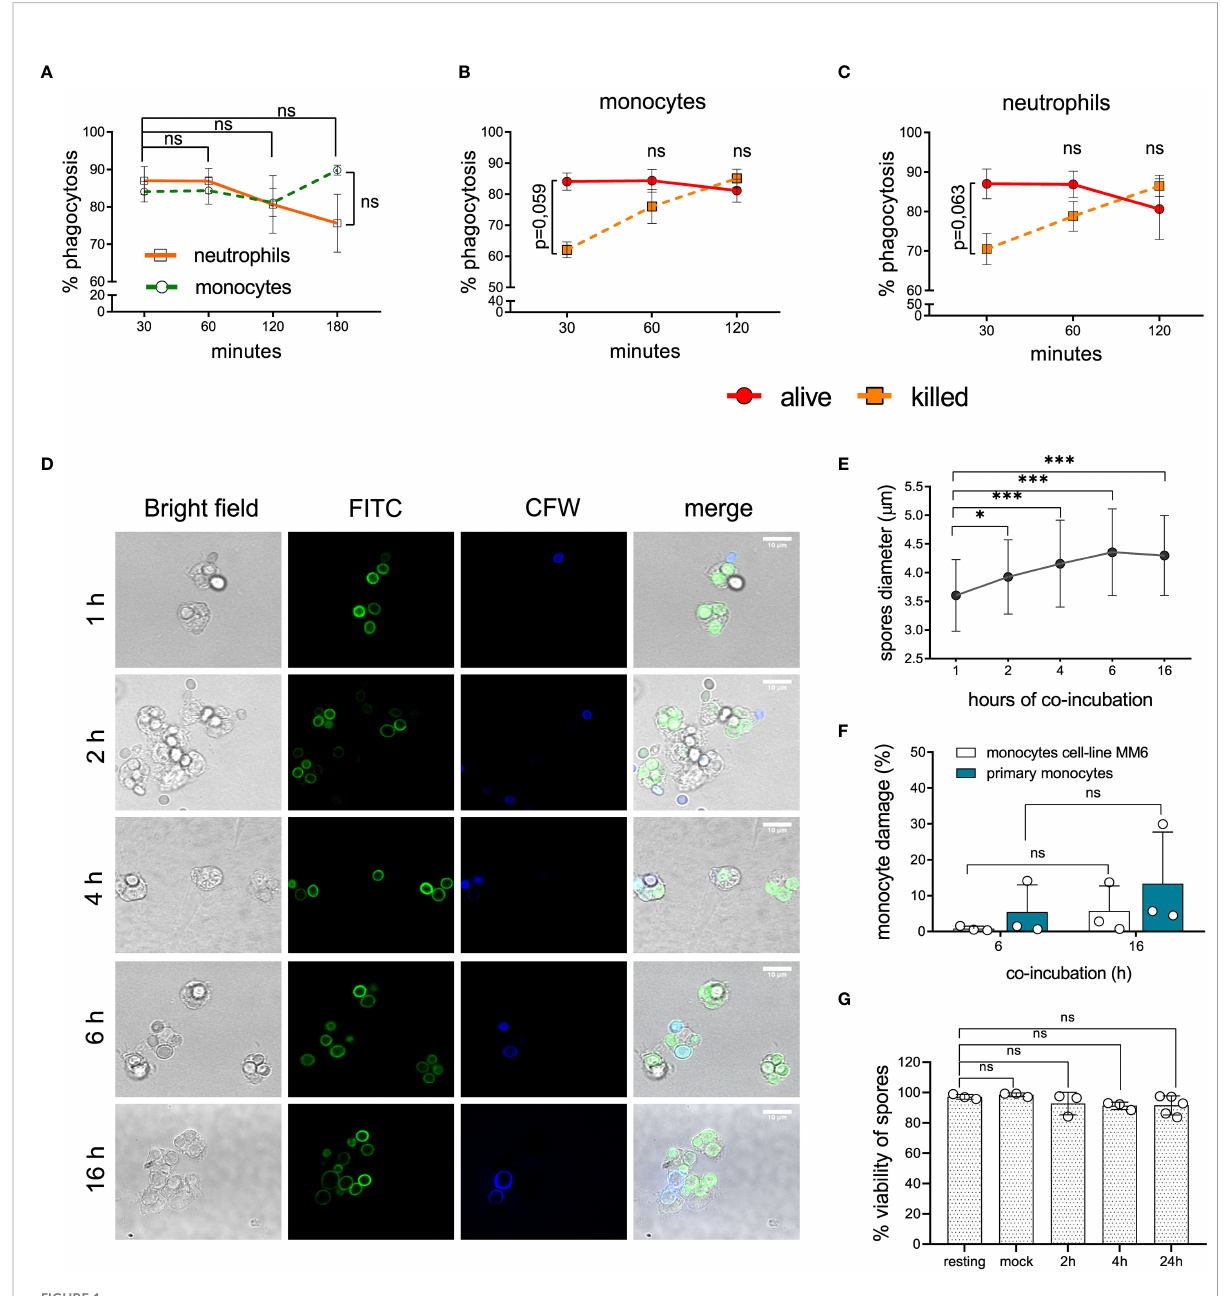
FIGURE 1 Recognition and intracellular fate of L. corymbifera dormant sporangiospores, here designated as resting spores. (A) Phagocytosis of resting spores by primary monocytes and neutrophils. (B, C) Phagocytosis of alive and killed fungal spores by monocytes and neutrophils. (D) Intracellular growth of L. corymbifera after phagocytosis by primary human monocytes. Fungal spores were pre-stained with FITC and counterstained with calco fl uor white (CFW) after phagocytosis to differentiate attached spores (blue) from internalized spores (green). (E) Diameter quanti fi cation of internalized spores (n=80/experiment). (F) Percentage of monocytes ’ LDH release after infection with L. corymbifera . (G) Viability of phagocytosed spores. Symbols and bars represent the mean ± SD of at least three independent experiments. Differences among groups were assessed by unpaired t test or one-way ANOVA. * p < 0,05; *** p <0,001. ns indicates not signi fi